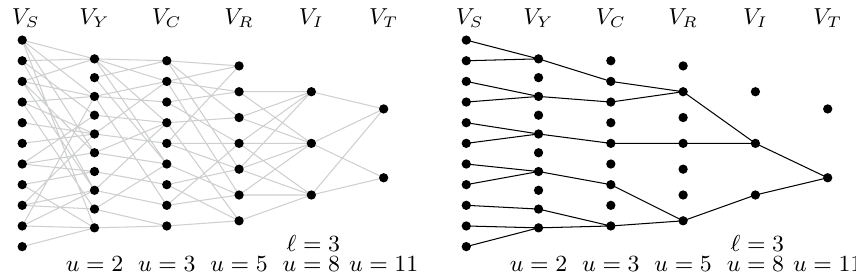
Fig. 1 An example instance of SoFaCLaP showing the layered graph and the capacities of all layers (left) and—assuming that there is a cable type with sufficient capacity—a feasible cable layout (right) . The flow values on the edges are omitted in this visualization. They are, however, uniquely determined, since the cable layout is cycle-free, and can be computed by counting the strings in the respective subtrees of the